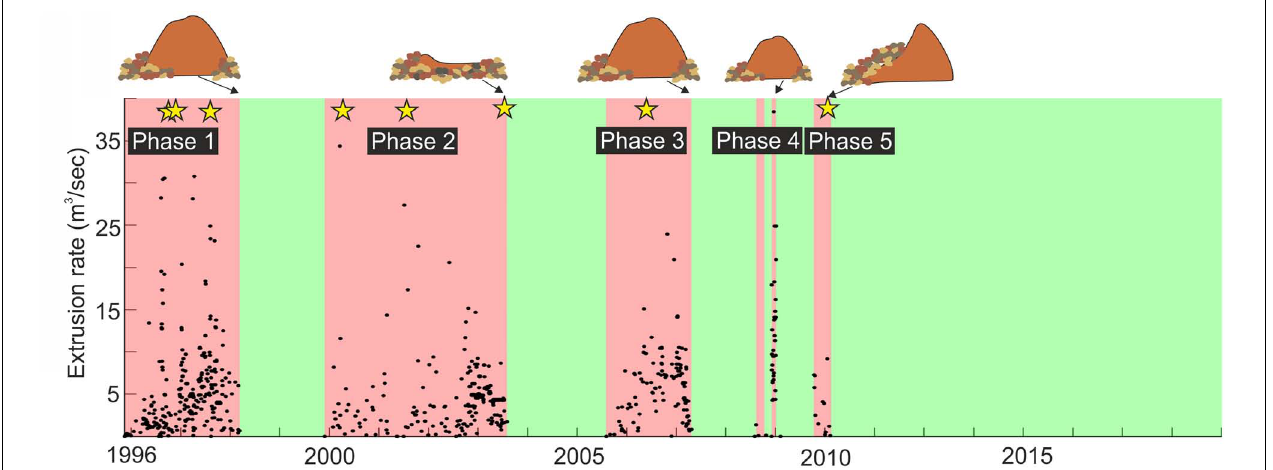
FIGURE 2 | Eruption history at Soufrière Hills, Montserrat. Extrusion rate data shown in black, calculated for Phases 1–4 using erupted volume data from Wadge et al. (2014) and extrusion data for Phase 5 from Stinton et al. (2014a). Red shows eruptive phases, whilst green shows pauses in activity. Annotations show state of the dome at the end of each phase (standing dome with relative size indicated, wholesale collapse, partial collapse), and stars mark major ( > 10 7 m 3 ) dome collapses across the eruption.